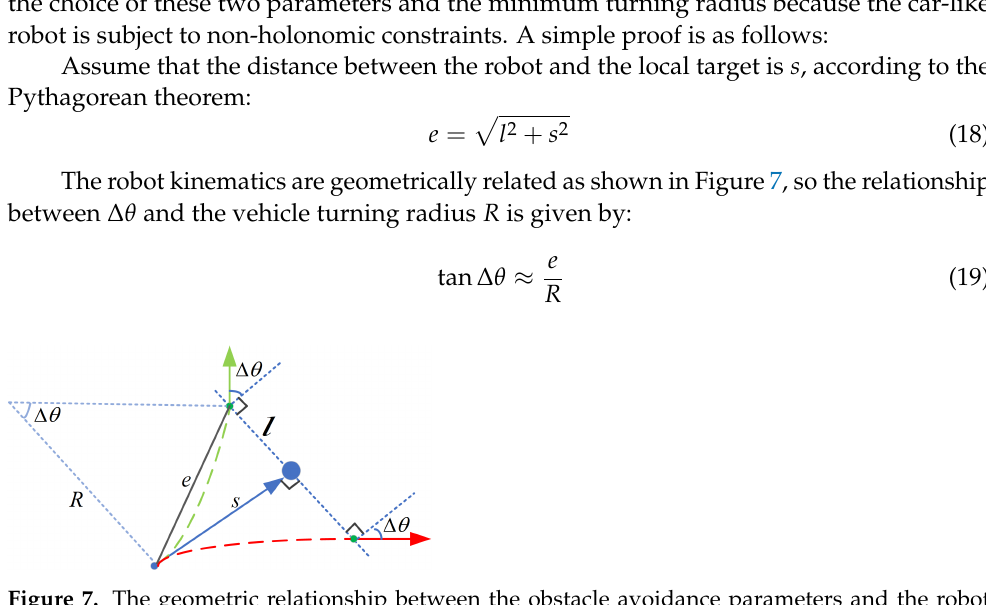
Figure 7. The geometric relationship between the obstacle avoidance parameters and the robot turning